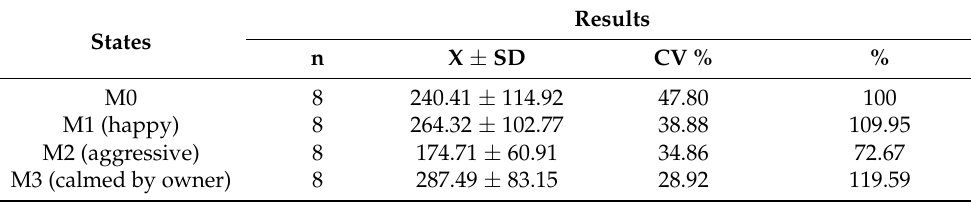
Table 3. The results of the serotonin value depending on the degree of individual involvement.